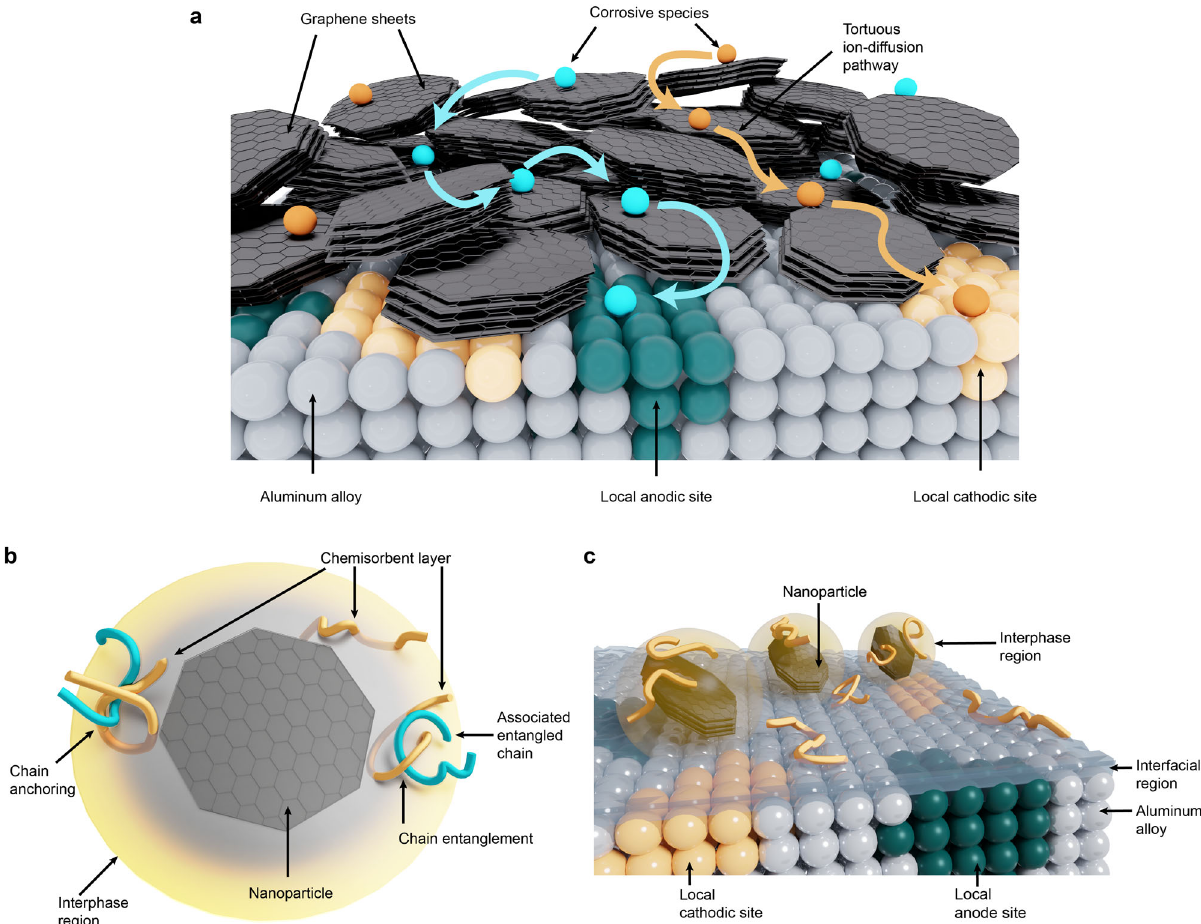
Fig. 1 Interphasal and Interfacial Interactions in UFG/PEI Nanocomposite Coatings on AA 7075 substrates. a Schematic illustrating the increased length of ion-diffusion pathways upon embedding of graphene within PEI; b a schematic of the interphase region created through inclusions of UFG with the PEI matrix; and ( c ) schematic illustrating interphase and interfacial regions that together form an effective barrier protecting AA 7075 substrates from corrosion.